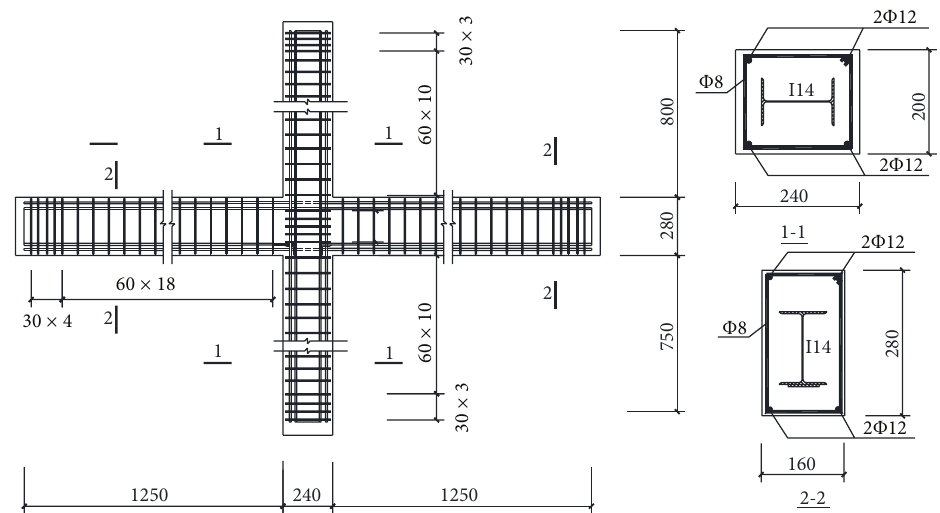
Figure 2: Cross section and distributed steel of beam-column assemblies.